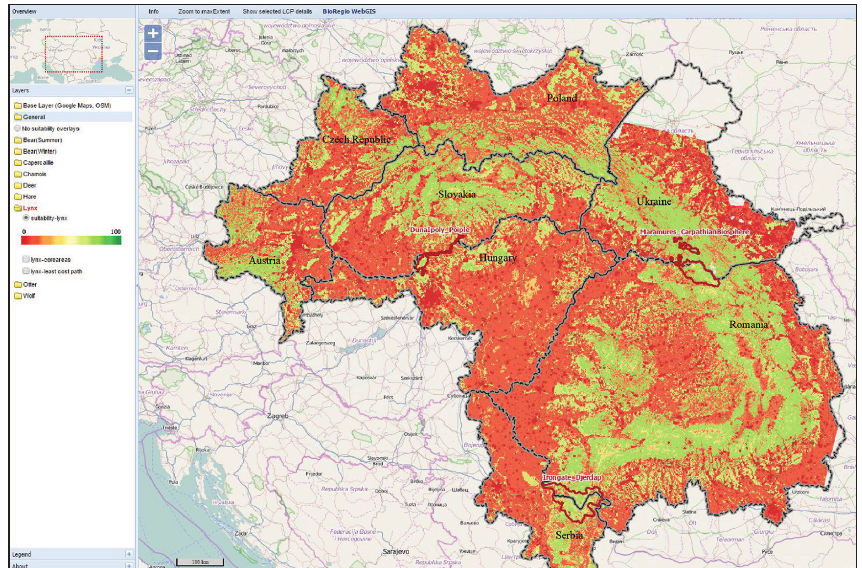
Figure 3. Web-GIS screenshot showing the Carpathians Habitat Suitability Map for the Lynx (from